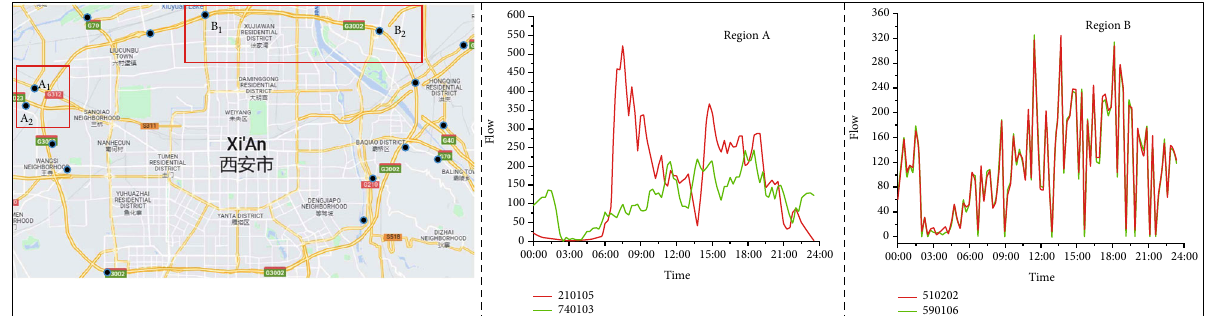
Figure 2: The special situation of toll-gate location and tra ffi c fl ow